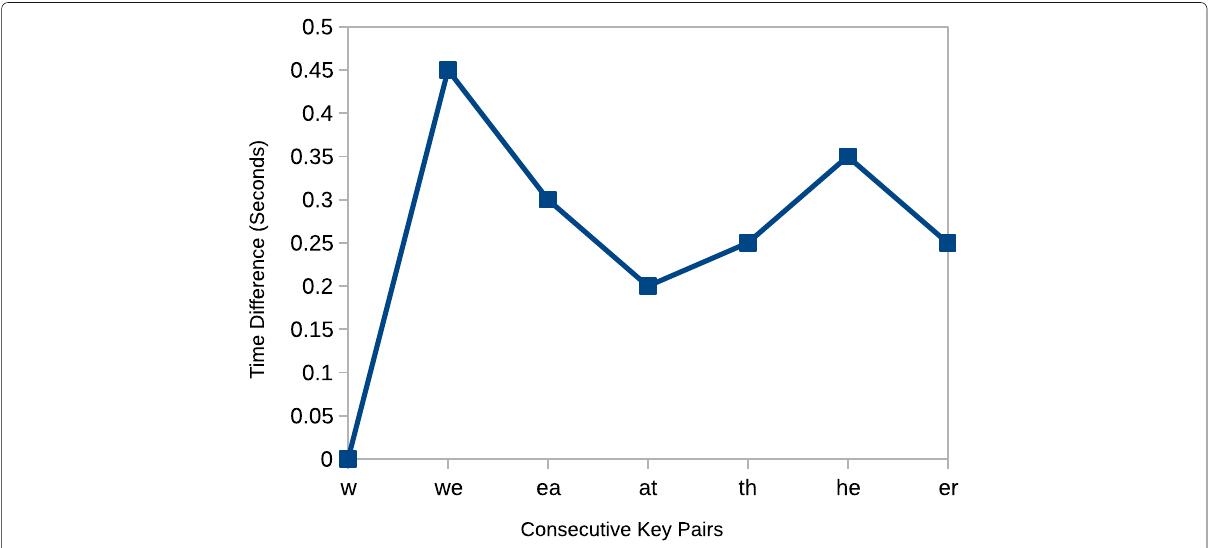
Fig. 4 Basic T 2 example (artificial data) for the phrase p 1 with time differences between each consecutive letter as features